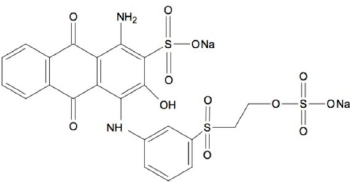
Figure 1. Chemical structure of the Remazol Brilliant Blue R dye